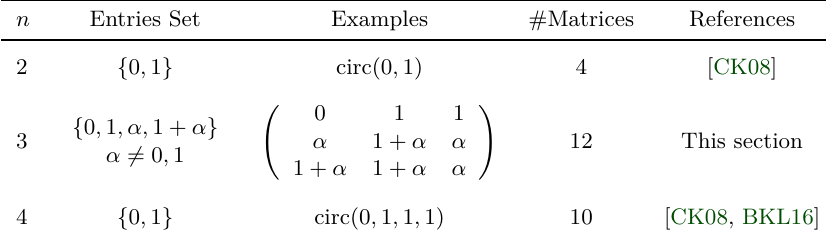
Table 6: Involutory near-MDS matrices of order less than or equal to